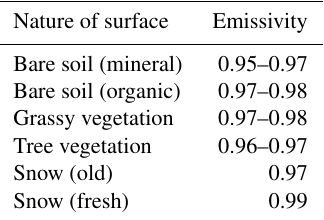
Table 3. Soil emissivity for surface types (Brutsaert,